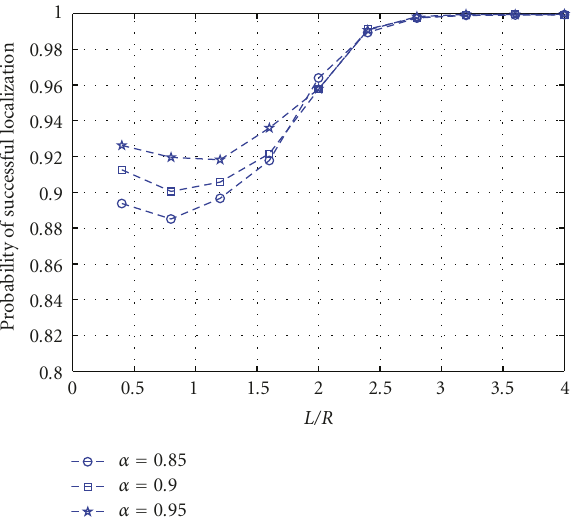
Figure 12: The e ff ect of α on mobility-aided TSCD scheme (the step length is 0 . 25 R